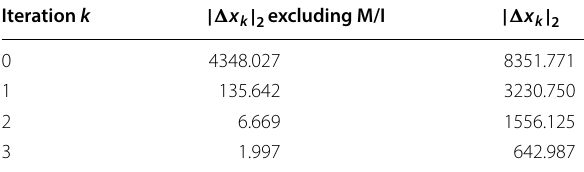
Table 2 LSLE-GN convergence for CIY4, where | (cid:31) x k | is the ℓ 2 norm of the adjustment vector (cid:31) x k in Eq. 8 and “M/I” denotes magnetospheric/induced parameters Iteration